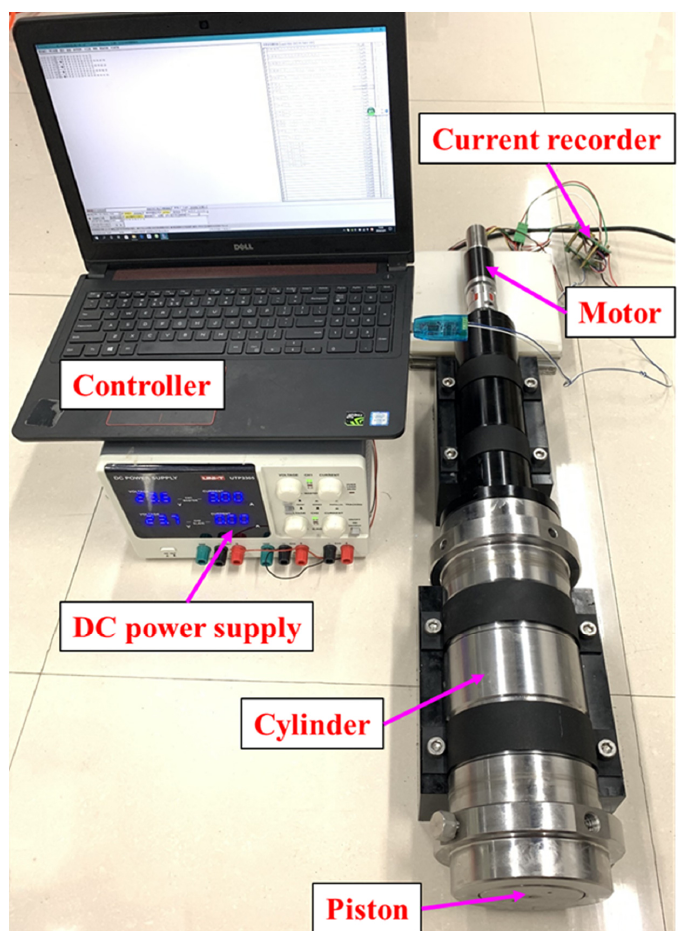
Figure 9. Mechanical model of the friction test.